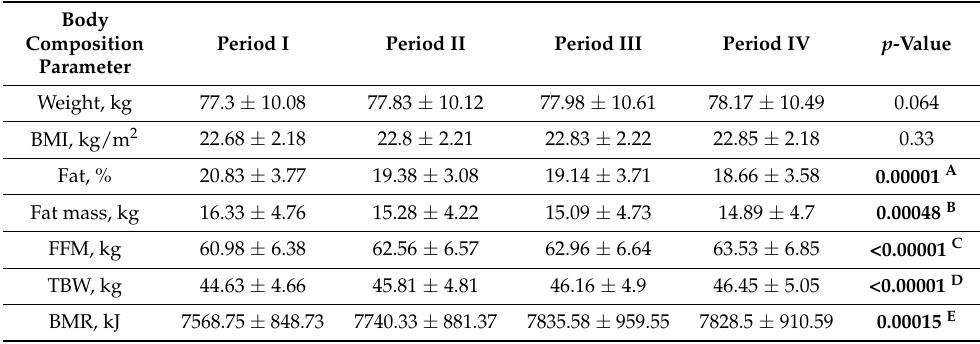
Table 2. The differences in body composition parameters between studied periods. Body Composition